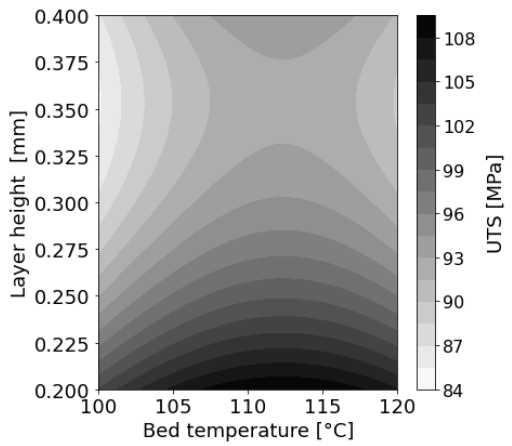
Figure A11. Contour plot for T bed and h according to the ML-based prediction model.